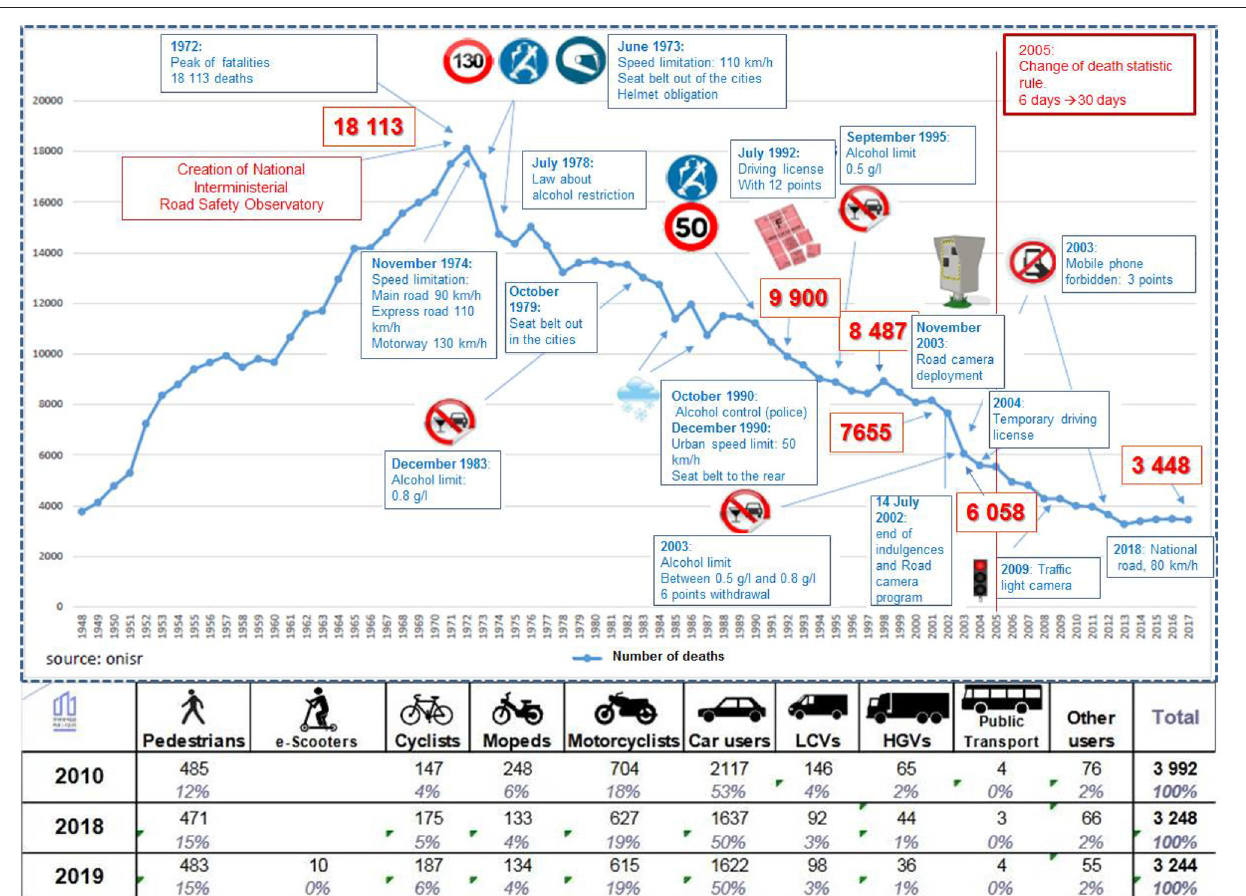
FIGURE 4 | Road crashes fatalities and injuries trends in France (National Inter Ministerial Road Safety Observatory: ONISR).